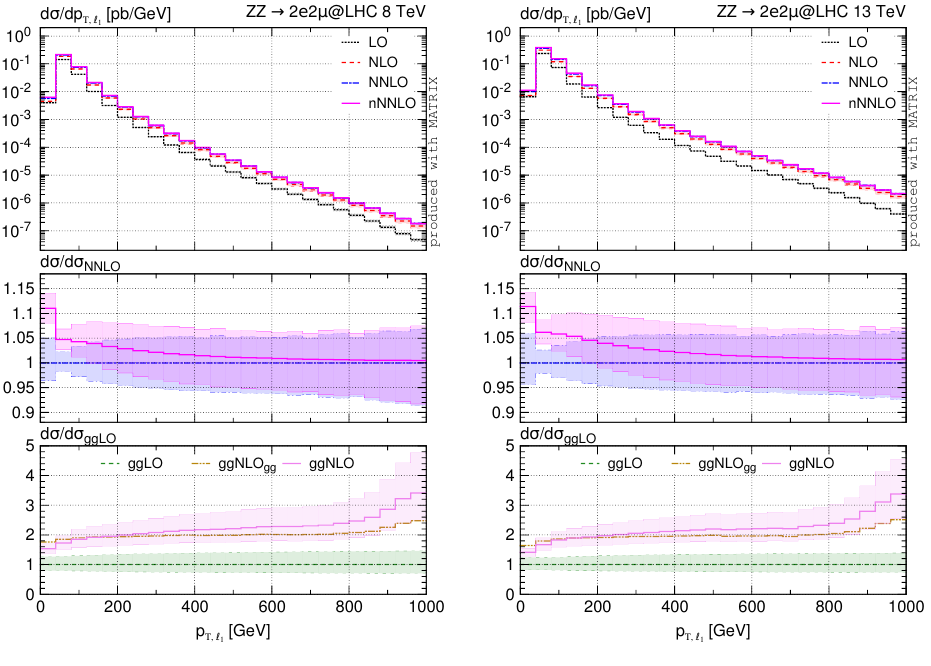
Figure 7 . Di(cid:11)erential distribution in p T;‘